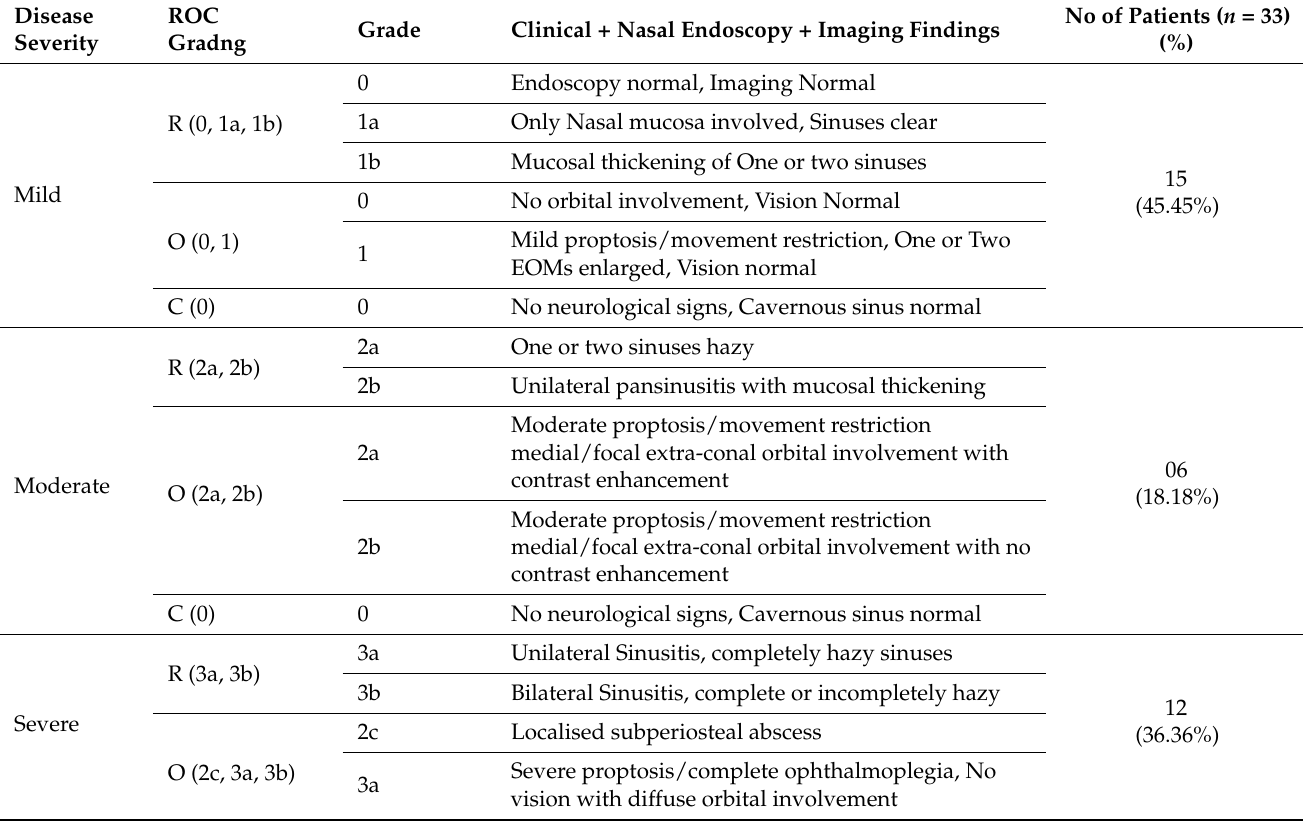
Table 1. ROCM Disease Severity Classification based on the ROC Staging of Naik et al. [12]. Disease